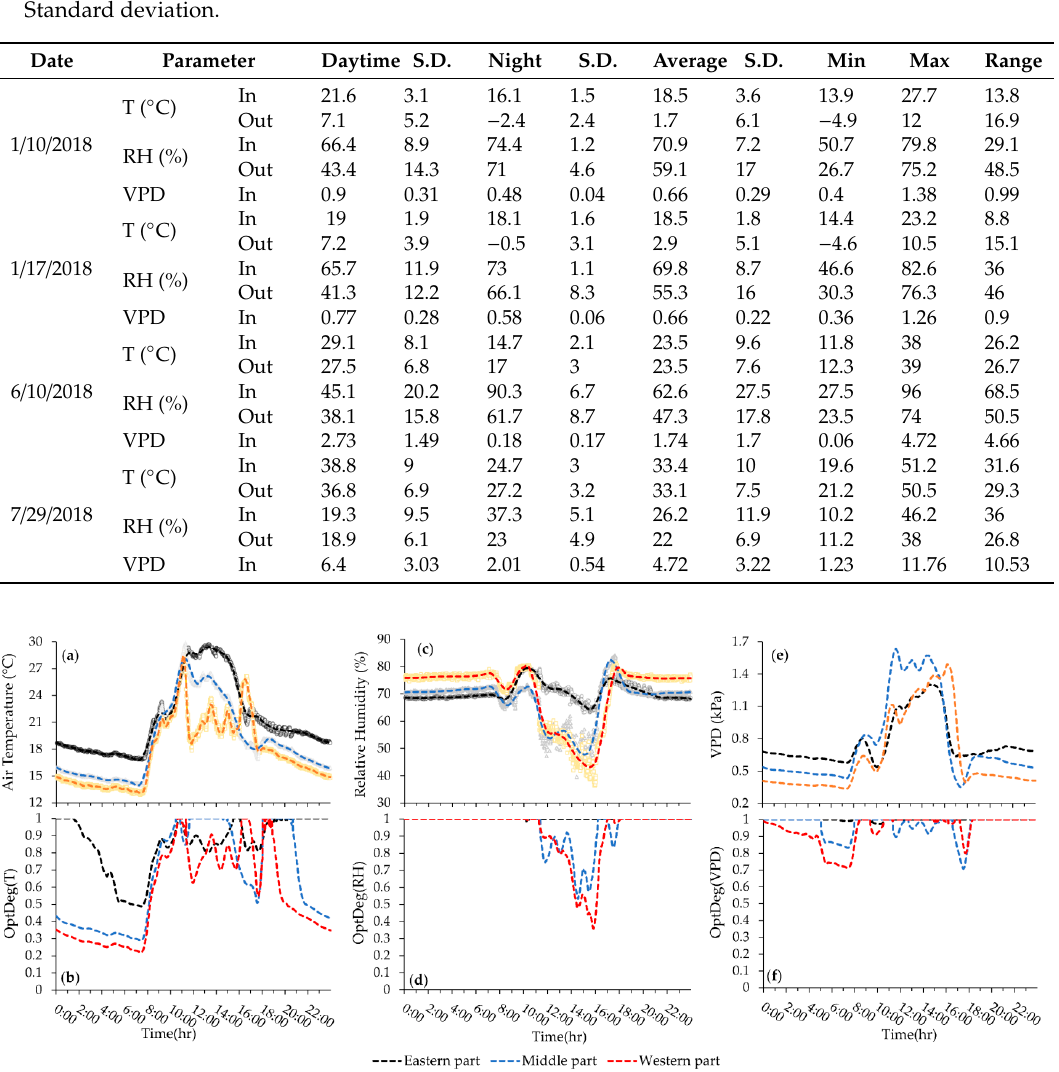
Figure 8. Hourly average variations of microclimate parameters and OptDeg at 10 January 2018. ( a ) air temperature; ( b ) OptDeg(T); ( c ) relative humidity; ( d ) OptDeg(RH); ( e ) vapor pressure deficit and ( f ) OptDeg(VPD).